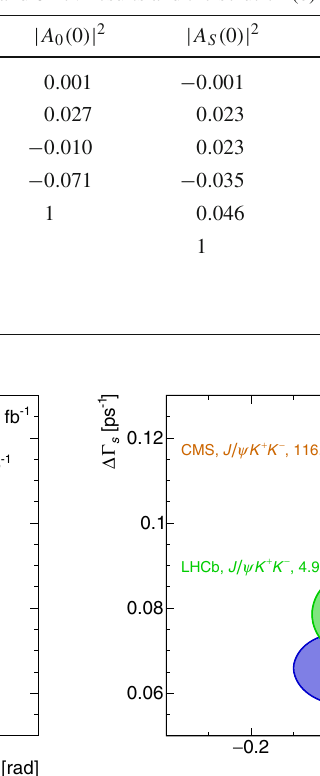
Table 11 Correlation matrix of the BLUE combination of the 7 and 8 TeV results and the solution (b) of the 13 TeV result